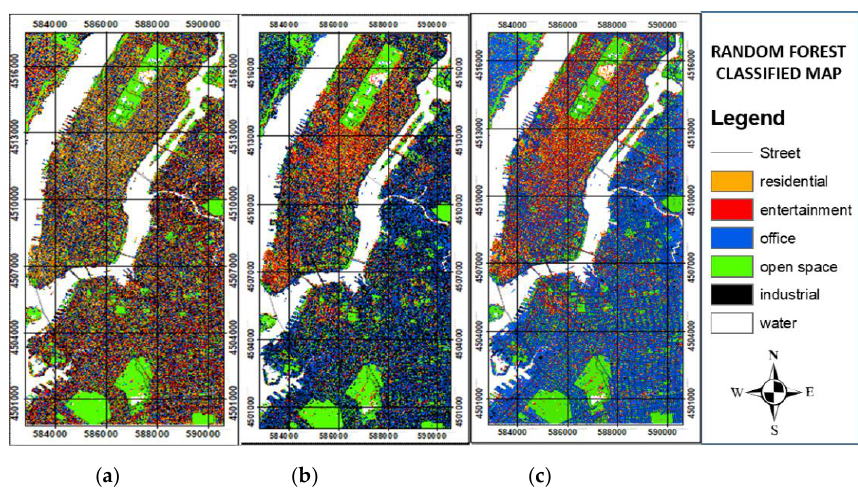
Figure 16. Six-class random forest classified map using ( a ) remote sensing only; ( b ) integration of remote and social sensing (without data cleaning); ( c ) integration of remote and social sensing (with data cleaning).